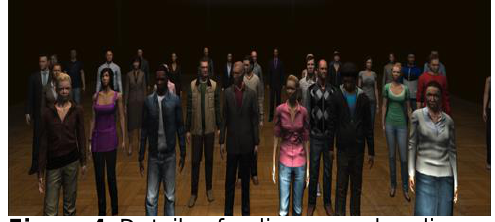
Figure 4. Details of a disengaged audience .